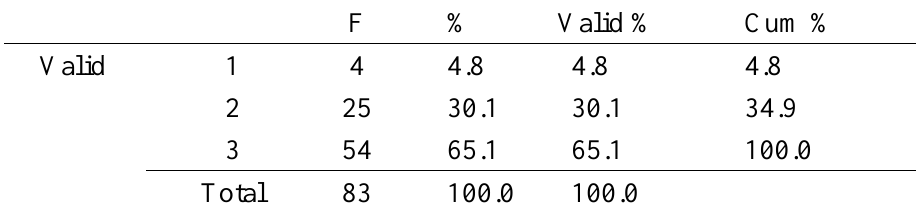
Tabel 6 . P8. Pendampingan Pengaksesan Media